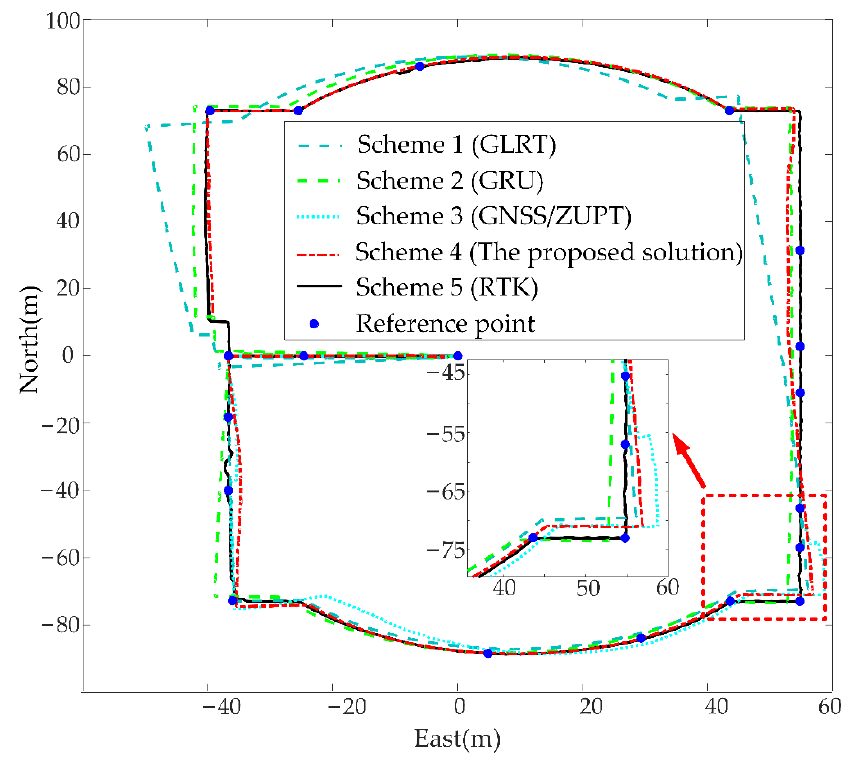
Figure 12. 2D positioning trajectories by different schemes.